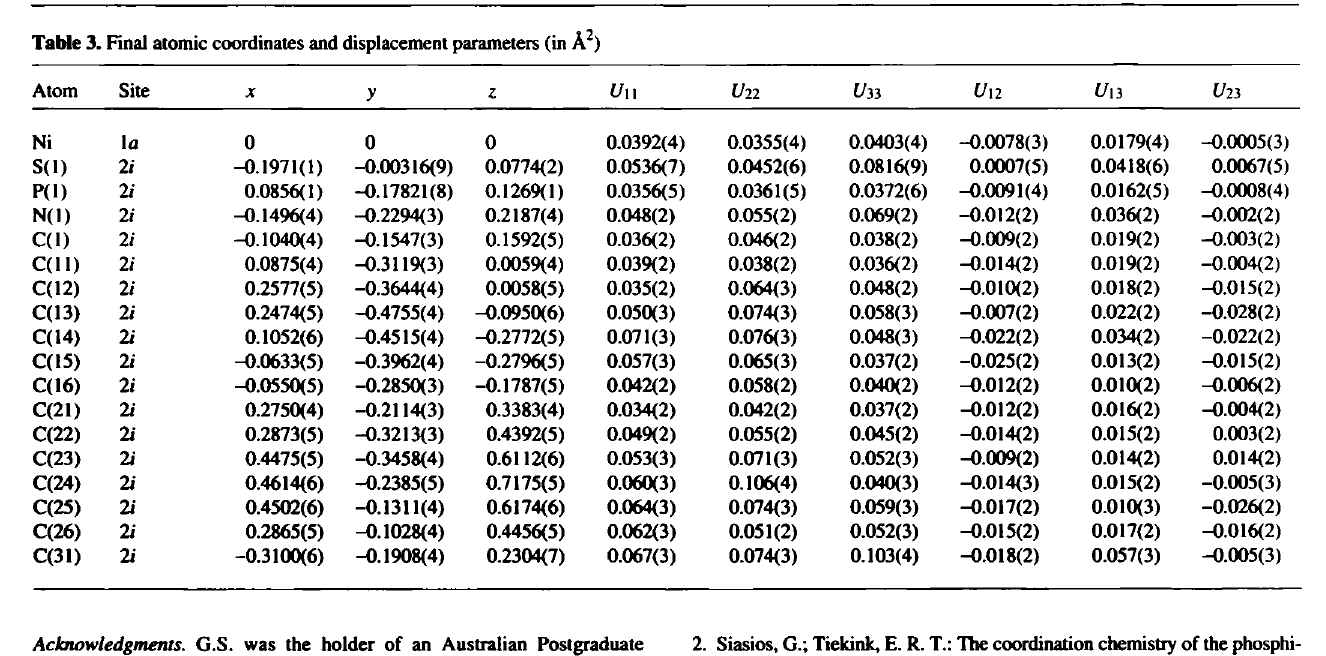
Table 3. Final atomic coordinates and displacement parameters (in Â 2